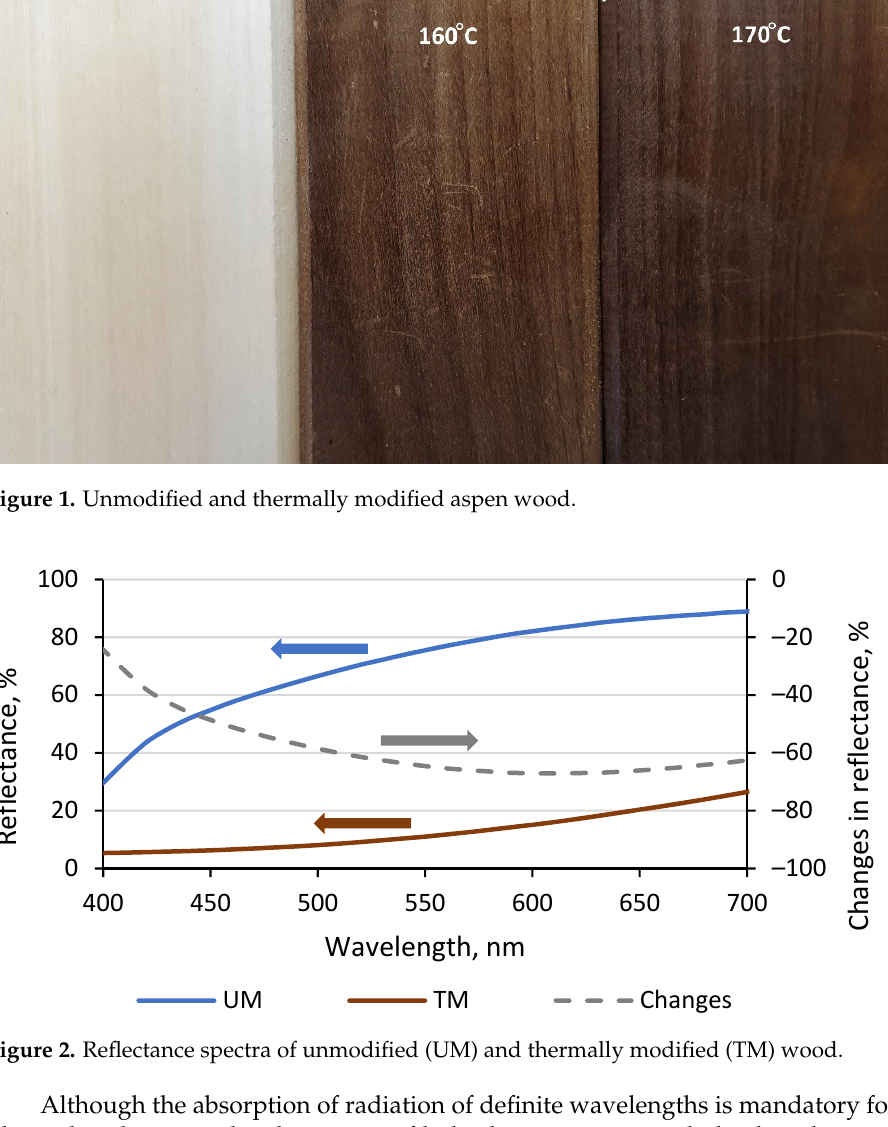
Figure 1. Unmodified and thermally modified aspen wood.